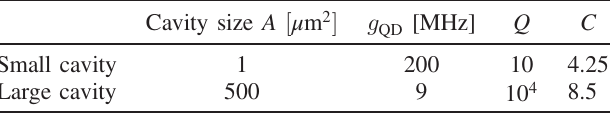
TABLE V. Estimates of the single-spin cooperativity C for a DQD singlet-triplet qubit with T ⋆ 2 ≈ 100 ns, in a SAW cavity at = 2 π ≈ 1 . 5 GHz and cryostat temper- gigahertz frequencies ω c ≈ 0 for both a small, low- Q and a large, high- atures where ¯ n th